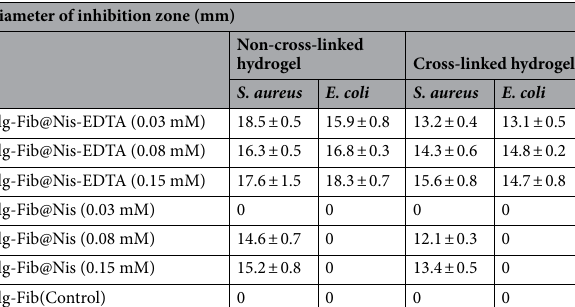
Table 1. Diameters of inhibition zones caused by different preparations of hydrogels in S. aureus and E. coli cultures. Values represent the mean ± SD, n = 3, SD: standard deviation.